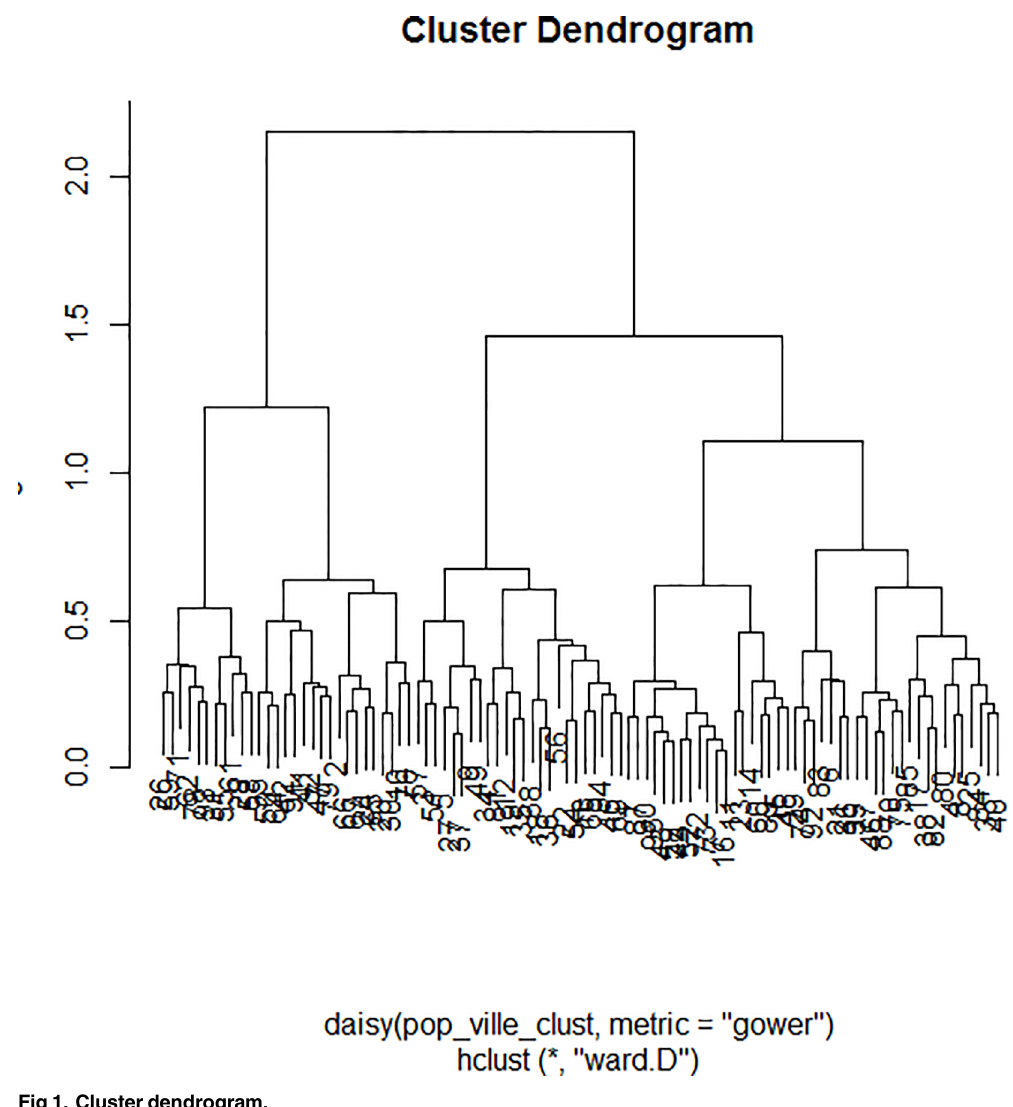
Fig 1. Cluster dendrogram. (PwG: 87% vs. PwP:63%) and lacked hygiene (PwG: 48% vs. PwP:26%). Frequently, patients were single (PwG: 61% vs. PwP:42%) with at least one dependent relative who did not live with them (PwG: 48% vs. PwP:19%) and had developed adaptative strategies to cope with this situa- tion (PwG: 39% vs. PwP:17%). This group was associated with greater use of paramedics (MwG: 253 vs. MwP: 89, p < 0.05), a higher age (MwG: 78 vs. MwP:71, p < 0.05) and a greater number of chronic diseases (MwG: 4.8 vs. MwP: 4, p < 0.05) than the population’s mean. Cluster 3. Twenty three patients were classified in this group. People with an addictive behavior (PwG: 61% vs. PwP:15%) and psychosomatic disease (PwG: 74% vs. PwP:38%) were over represented. In this context, an important proportion experienced marital problems (PwG: 30% vs. PwP: 8%), financial and social insecurity (PwG: 43% vs. PwP: 19%). An unhealthy diet (PwG: 78% vs. PwP: 52%), excess weight (PwG: 56% vs. PwP: 33%) and failure to comply with screening (PwG: 52% vs. PwP: 32%) were frequently combined. Usually the FPs managed to propose therapeutic education (PwG: 43% vs. PwP: 22%) for which they may